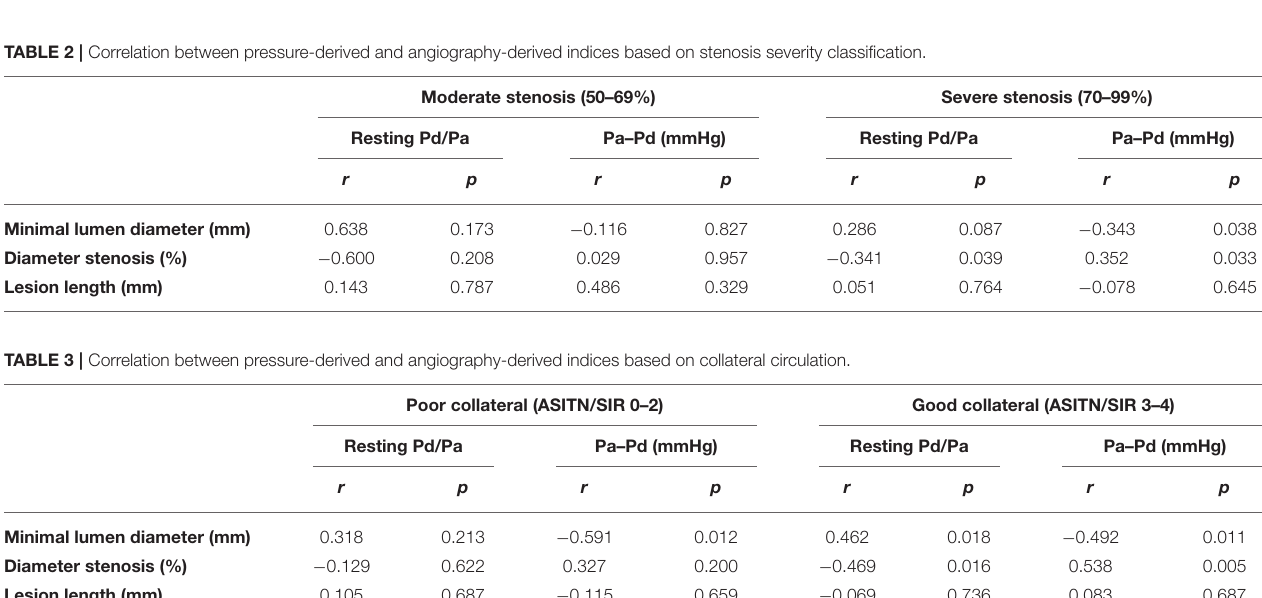
FIGURE 2 | Scatter plots showing correlation between translesional pressure gradient and lesion geometry. (A) Pd/Pa vs. diameter stenosis; (B) Pd/Pa vs. minimal lumen diameter; (C) Pd/Pa vs. lesion length; (D) Pa-Pd vs. diameter stenosis; (E) Pa-Pd vs. minimal lumen diameter; (F) Pa-Pd vs. lesion length. Pd indicates distal pressure of stenosis; and Pa indicates proximal pressure of stenosis. ※ indicates Spearman test for non-normally distributed variables; and † indicates Pearson test for normally distributed continuous variables.